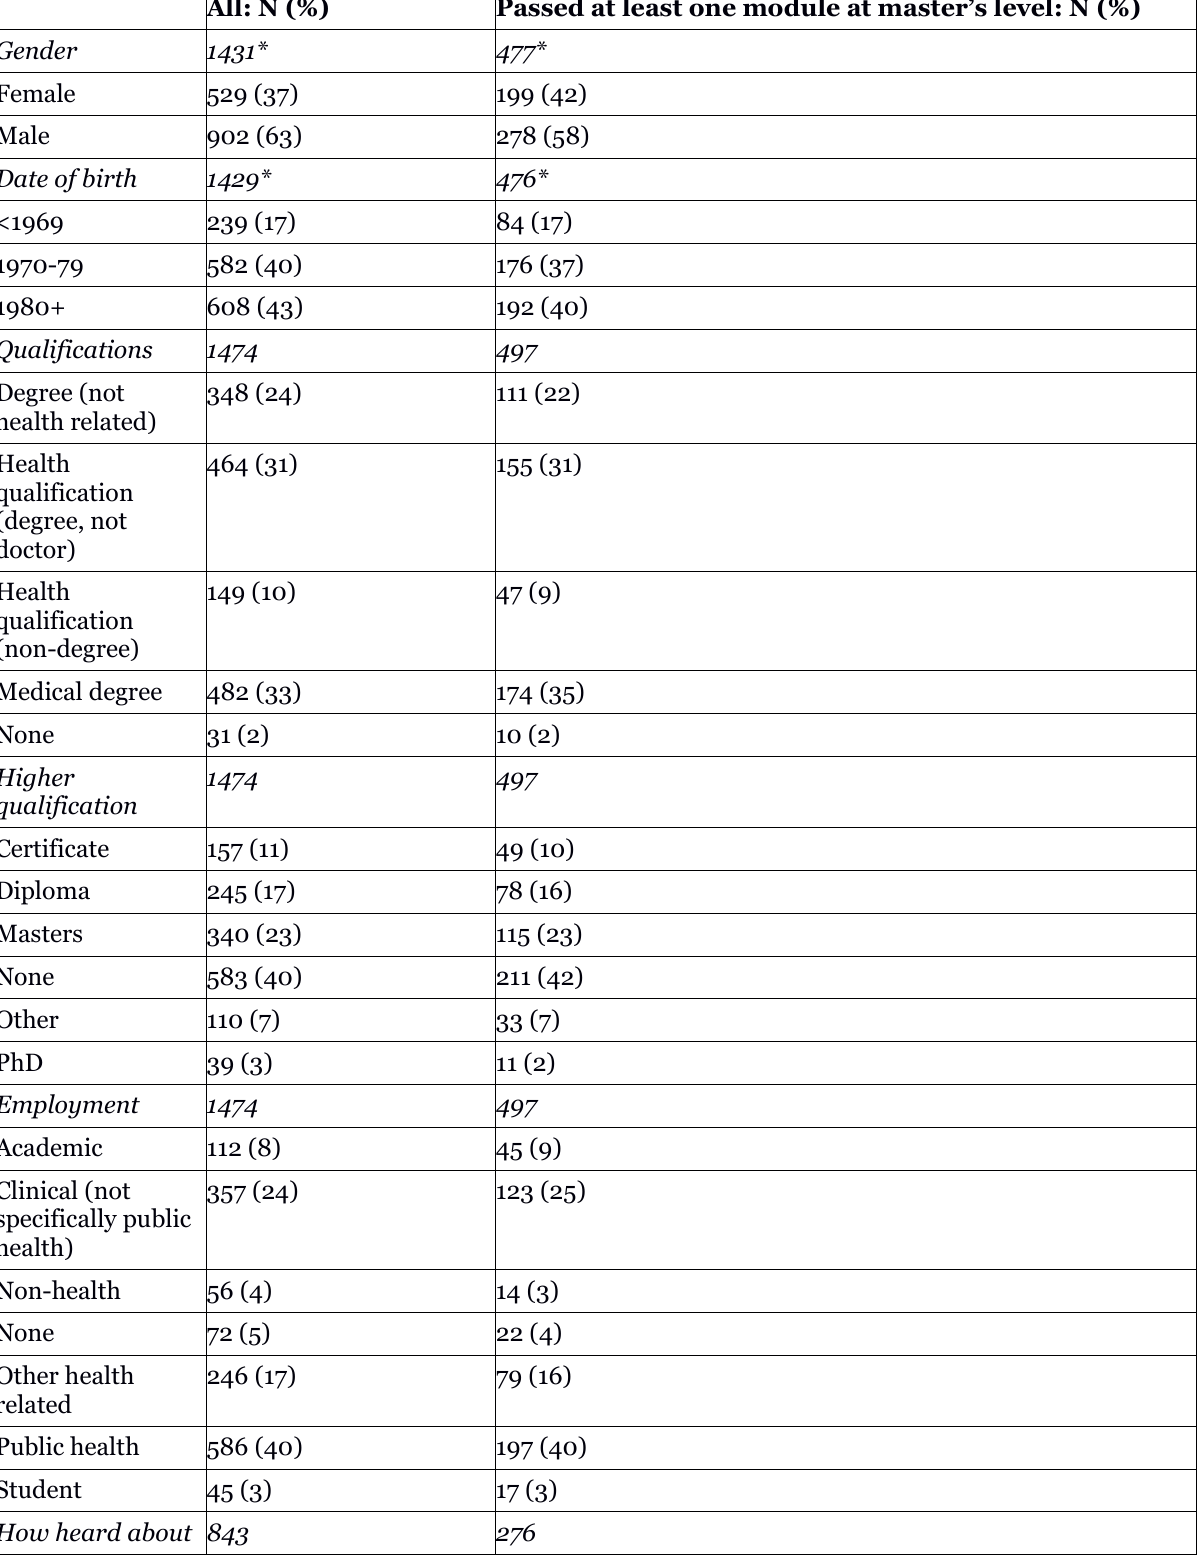
Table 2 Characteristics on Initial Enrolment of 1,474 Total Students and 497 Students Who Passed at Least One Module at the Master’s Level: Percentages are of Denominators (N) in Each Column